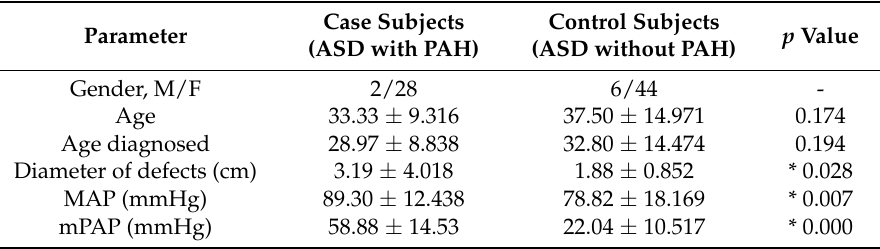
Table 2. Clinical characteristics of PAH patients and control subjects.